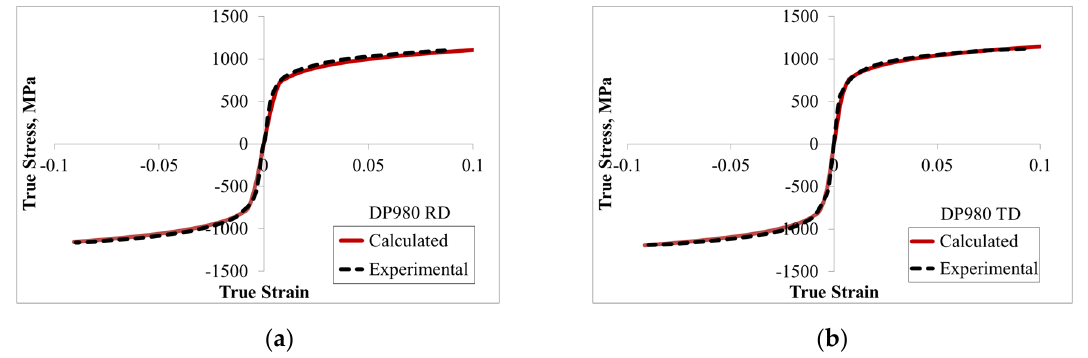
Figure 4. Experimental and fitted true stress and strain in tension and compression of DP980 steel in the ( a ) rolling direction and ( b ) transverse direction. Table 3. Material parameters of DP980 sheets used in the analytical and numerical methods.